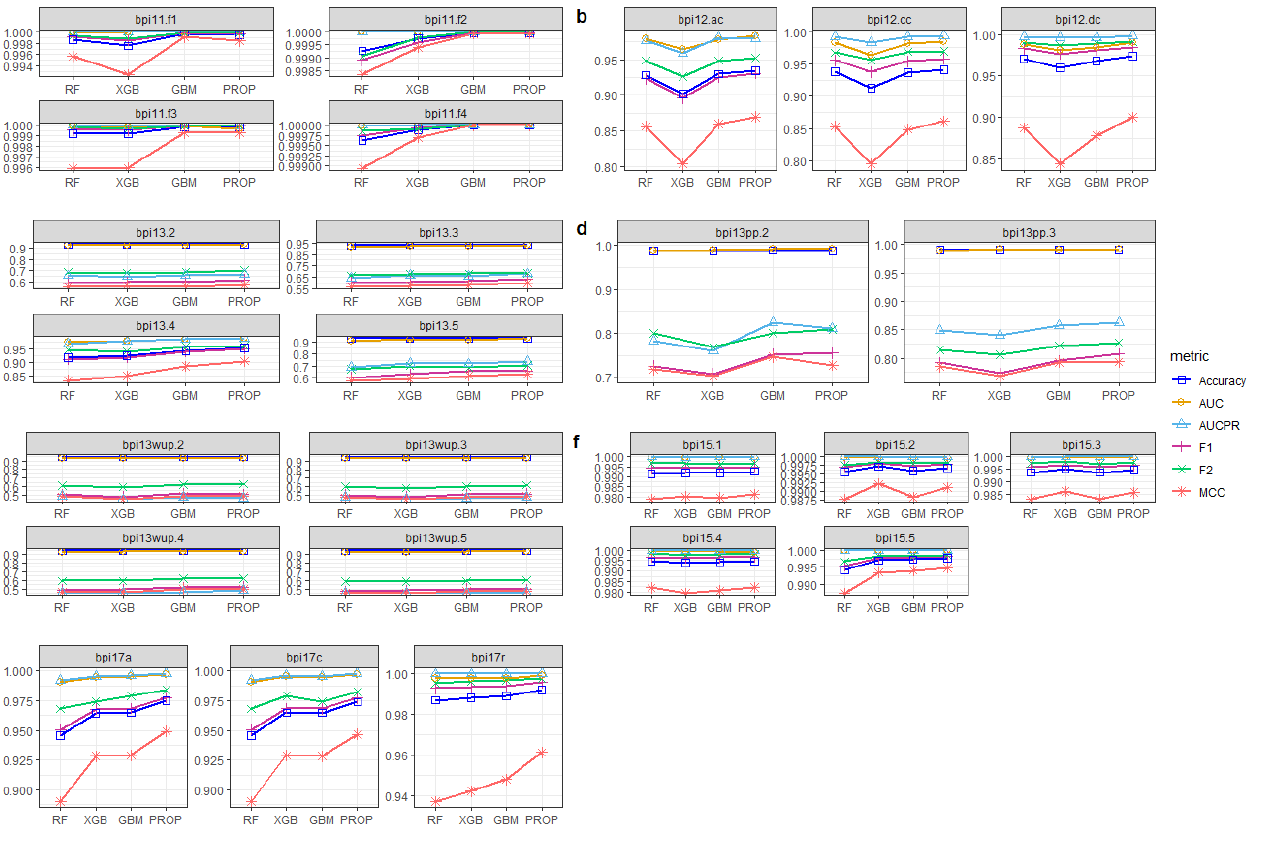
Figure 1. ( a – g ) Performance comparison between the proposed ensemble (e.g., PROP) and its base learners across different datasets in terms of mean accuracy, AUC, AUCPR, F1, F2, and MCC scores.